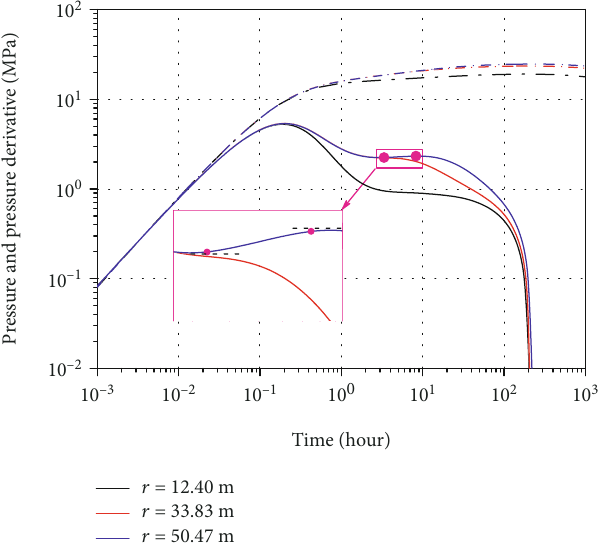
Figure 15: E ff ect of radius of the inner region on the pressure transient response. r denotes the radius of the inner